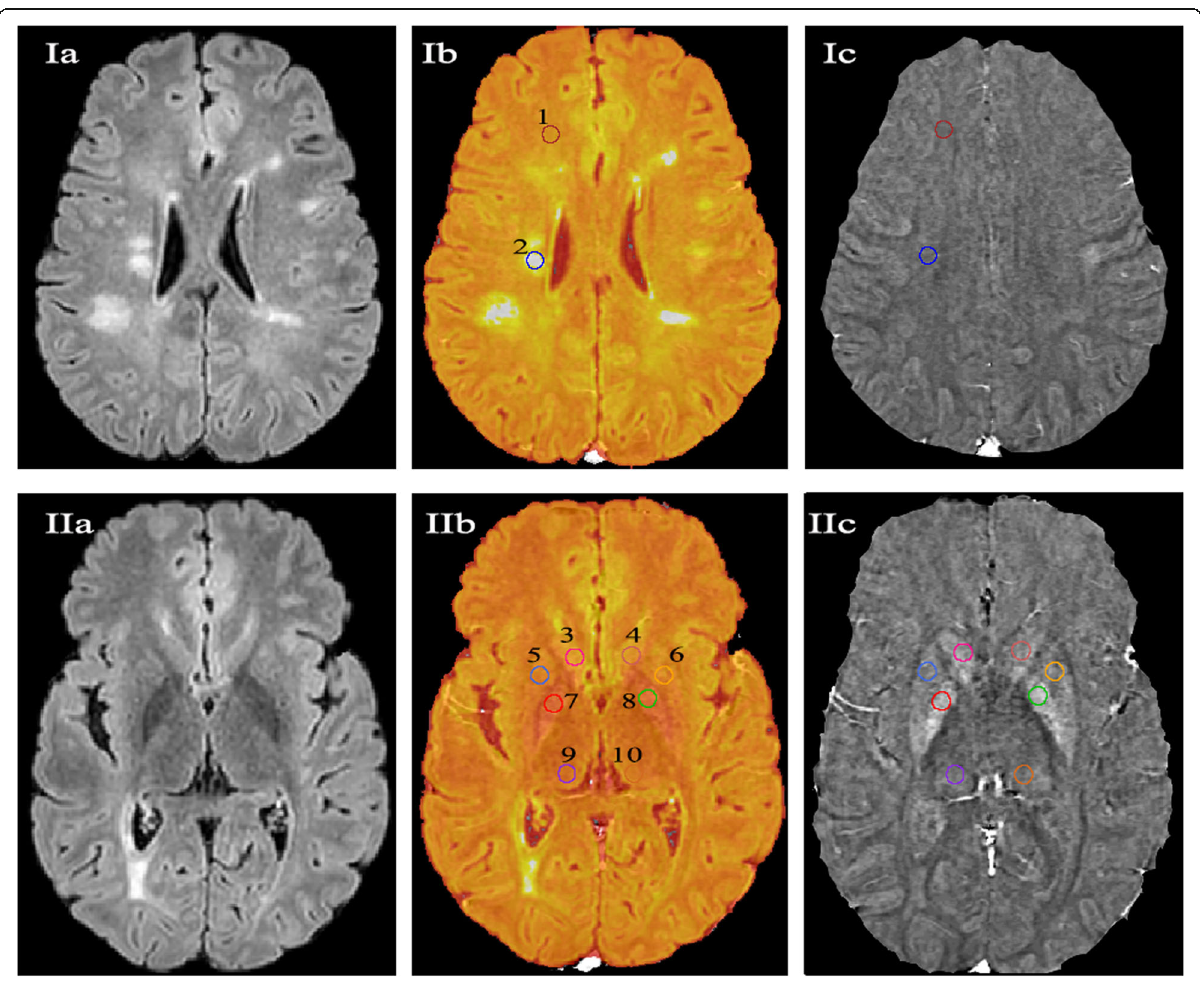
Fig. 3 Measurement of regional iron in a 25-year-old man with MS. Images Ia , Ib , and Ic represent the steps of measuring iron concentrations in the normal appearing white matter (region of interest [ROI] 1) and multiple sclerosis lesions (ROI 2). Ia is an axial three-dimensional fluid- attenuation inversion recovery (3D FLAIR) film demonstrating the MS lesions. Ib is the 3D FLAIR image overlayed onto the quantitative susceptibility mapping, and Ic is the quantitative susceptibility map. Similar steps are demonstrated in IIa , IIb , and IIc to measure iron concentrations in the deep grey matter: caudate (ROIs 3 and 4), putamen (ROIs 5 and 6), globus pallidus (ROIs 7 and 8), and thalami (ROIs 9 and